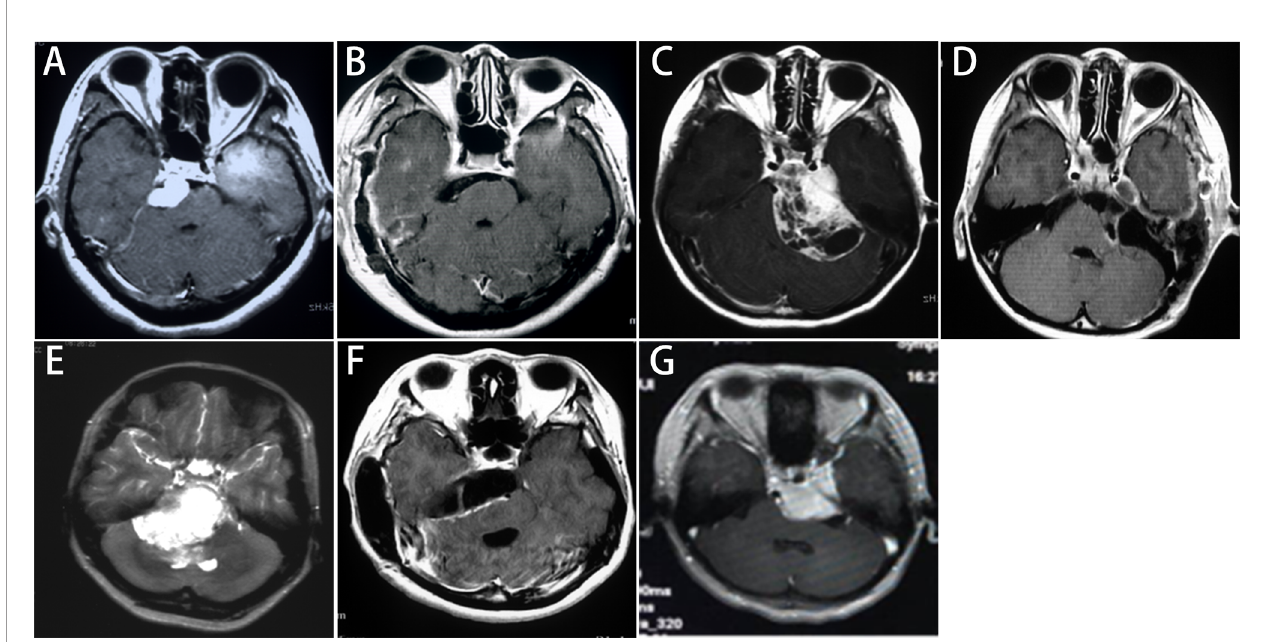
FIGURE 1 | Imaging classi fi cation and selection of surgical approaches for PCMs. Petrous apex type: (A) The preoperative enhanced MRI shows that the subtemporal transtentorial approach was used; (B) The MRI within postoperative 72 hours shows a Simpson grade I resection. Tentorium type: (C) The preoperative enhanced MRI shows that the retrosigmoid approach was used; (D) The MRI within postoperative 72 hours shows that the tumor invading the posterior wall of the cavernous sinus was removed, yielding a Simpson grade II resection. Upper clivus type: (E) The preoperative enhanced MRI shows that the anterior sigmoid approach was used; (F) The MRI within postoperative 72 hours shows a Simpson grade II resection. Cavernous type: (G) The preoperative enhanced MRI shows that the Kawase approach was used, and a Simpson grade III resection was